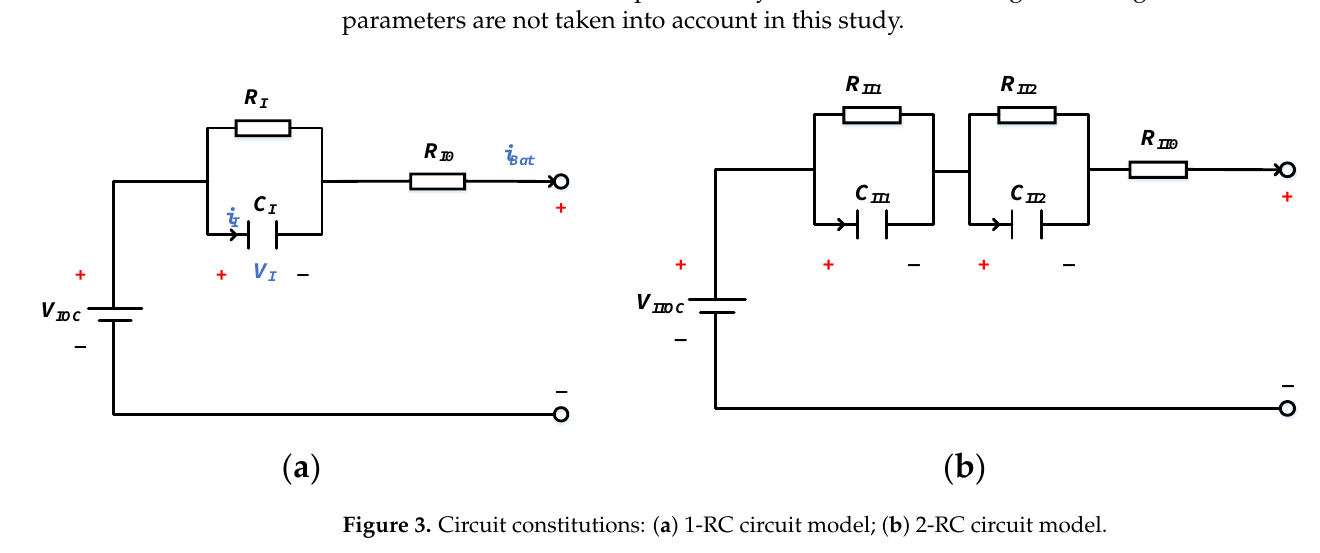
Figure 3. Circuit constitutions: ( a ) 1-RC circuit model; ( b ) 2-RC circuit model.